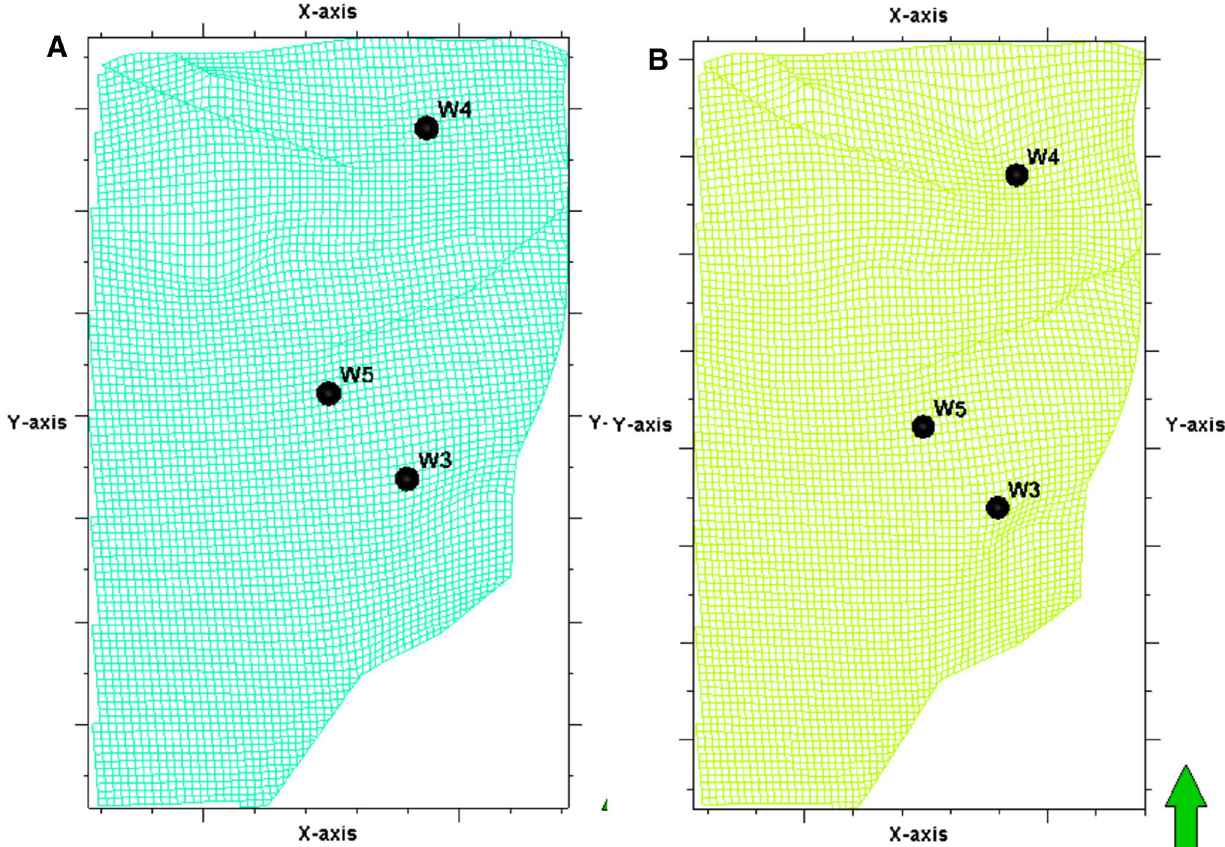
Fig. 5 2D pillar grid of the study area, established with geometric volume modeling method. a the middle pillar grid; b the base pillar